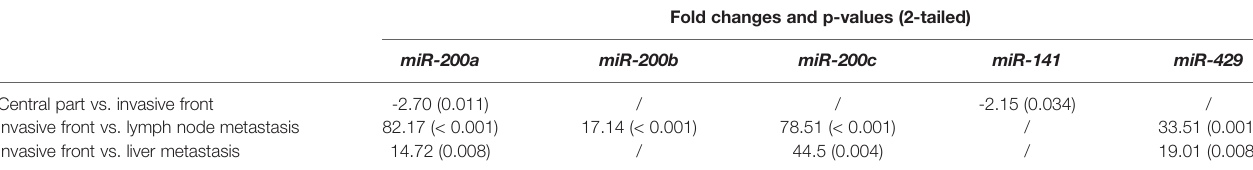
Fold changes and p-values